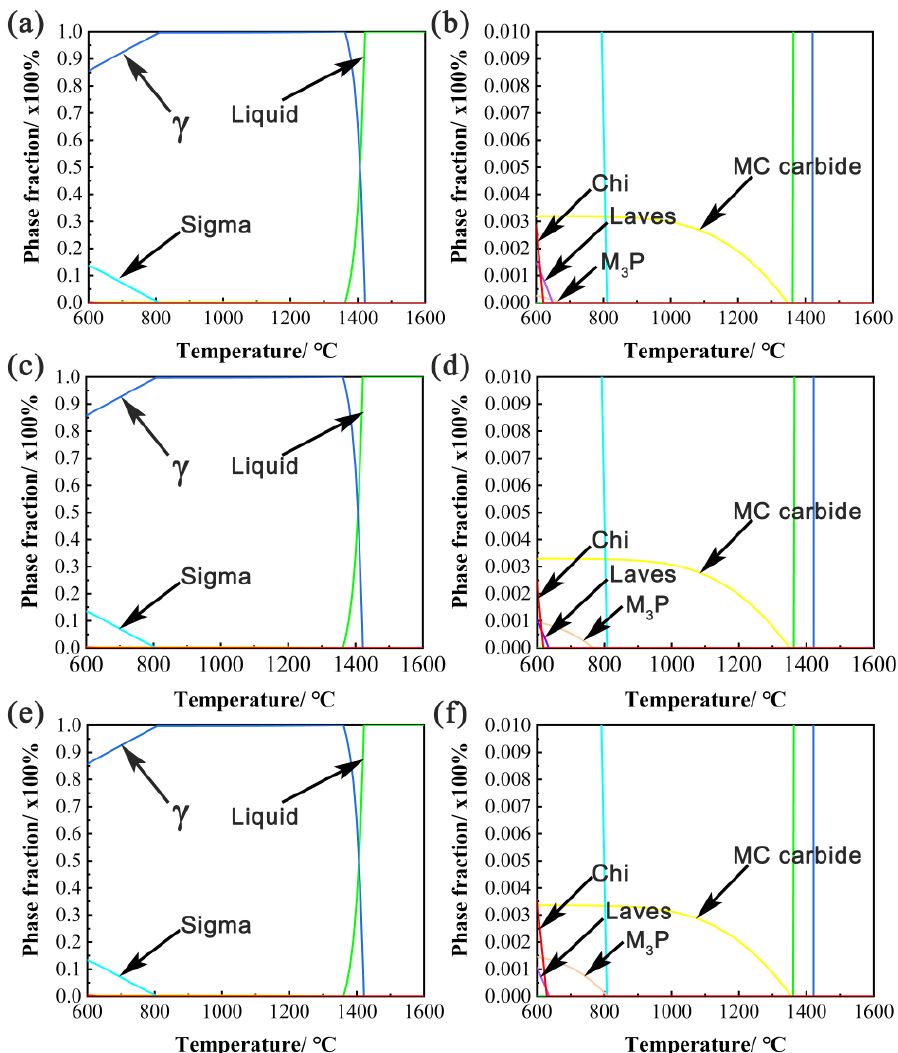
Figure 1. 15Cr–15Ni–Ti–xP alloy equilibrium phase fractions of precipitates calculated with Thermo-Calc2016b. The whole and part of phase diagram about relationship between phases and temperature for ( a , b ) 15Cr–15Ni–Ti–70P alloy, ( c , d ) 15Cr–15Ni–Ti–150P alloy and ( e , f ) 15Cr–15Ni–Ti–250P alloy.